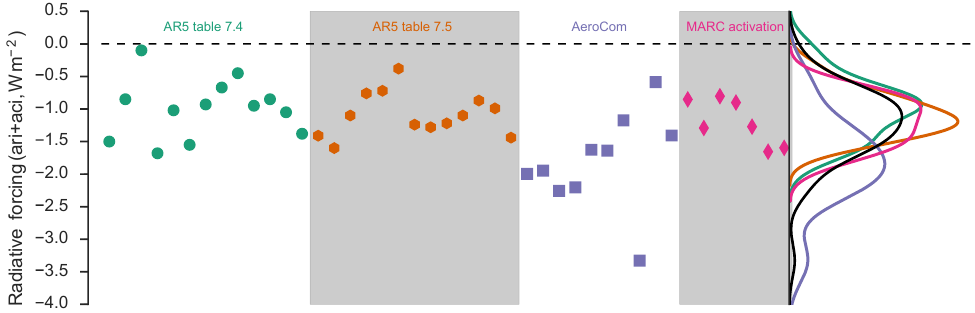
Figure 13. Comparison between estimates of ERFari + aci derived here and a subset of those previously reported by the IPCC AR5. Cor- responding kernel density estimates of the distribution of ERFari + aci are given in the right-hand panel; the solid black curve shows the distribution accounting for all the estimates on the